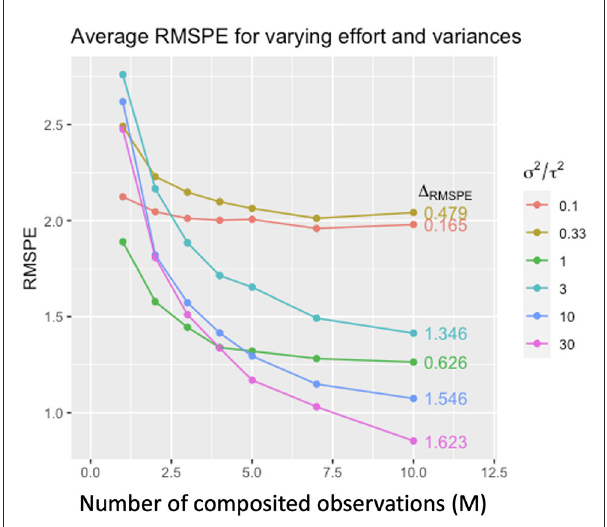
FIGURE4 Average root mean square prediction error (RMSPE) for simulated composite Gaussian data under varying M (number of composited observations), within-site variance σ 2 and between-site variance τ 2 . Colors denote the ratio σ 2 /τ 2 , and 1 RMSPE denotes the difference RMSPE M = 1 − RMSPE M = 10 . Prediction performance improves with increasing M , but the amount of improvement depends on the relative magnitudes of σ 2 and τ 2 . The more σ 2 dominates τ 2 (i.e., large σ 2 /τ 2 ), the larger the improvement in predictive performance with increasing m (from 1 RMSPE = 0.165 in red to 1 RMSPE = 1.623, purple).